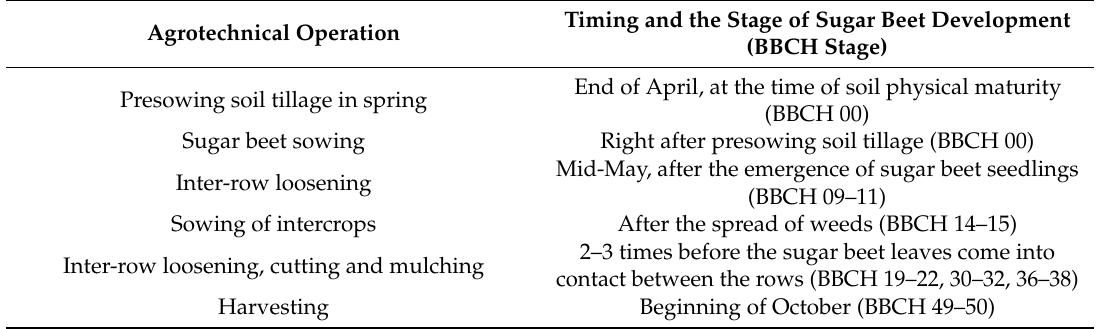
Table 1. The agrotechnical operations of the experiment (according to Romaneckas et al.